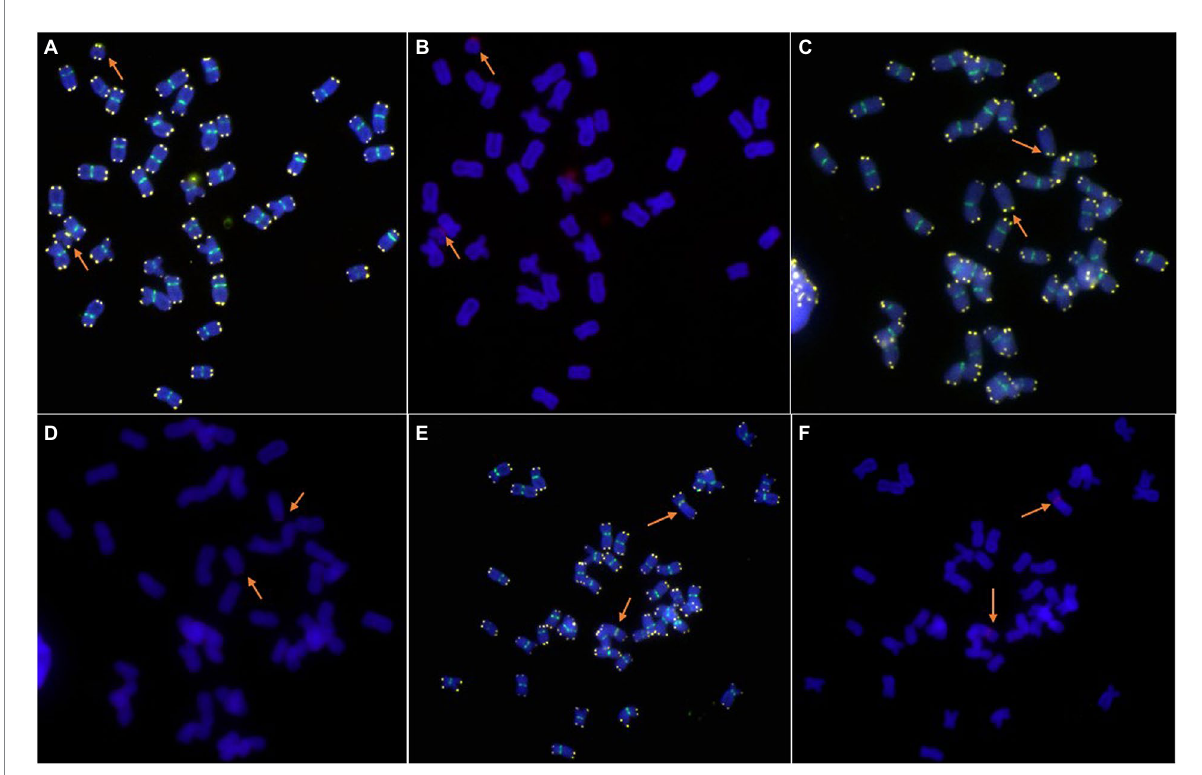
FIGURE 3 Cytogenetic analysis of the telomeres and centromeres of new lines by ND-FISH. (A,B) : 6RS ditelosomic addition line. The signal patterns were derived from one cell. (C,D) : 6RL ditelosomic addition line. The signal patterns were derived from one cell. (E,F) : 6R disomic addition line. The signal patterns were derived from one cell. Oligo-CCS1 (green), Oligo-PAWRC.1 (red), and Oligo-Telo (white). The arrows show the 6RS, 6RL, or 6R